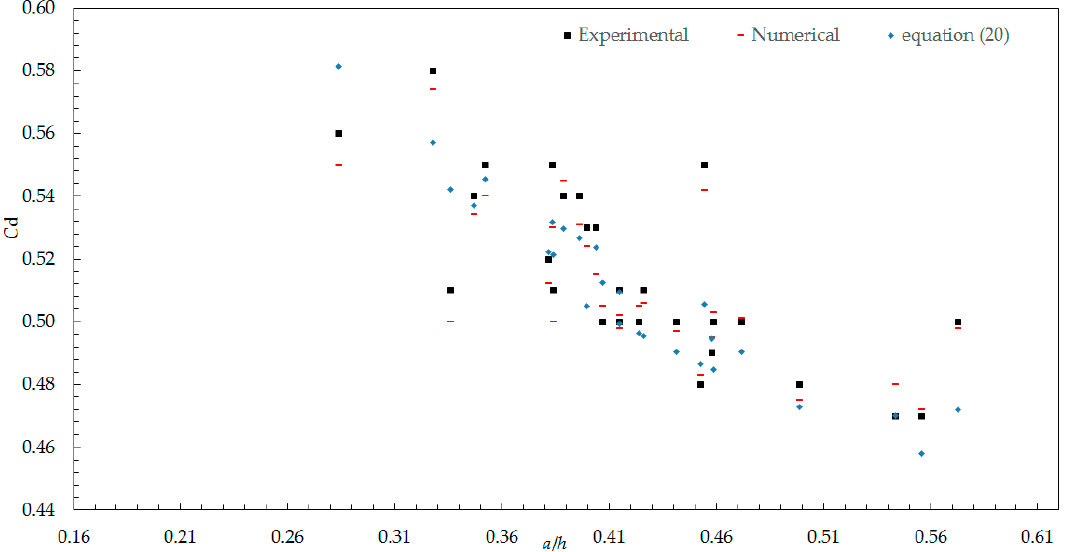
Figure 8. Comparison of experimental, numerical and values given by Equation (20) of the discharge coefficients ( C d ), Series 3.